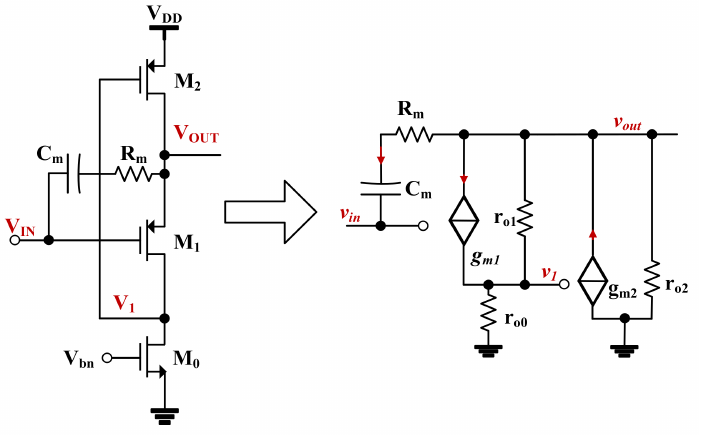
Figure 5. The equivalent small-signal model of the FVF buffer with the proposed R m -C m pair for frequency